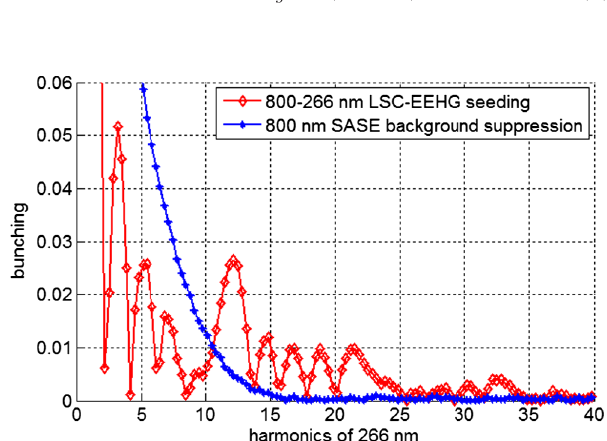
FIG. 5. 3D beam harmonics of 266 nm after last chicane for seeded and lasing suppressed portions of the beam from Fig. 4. Seeding was done with 800 nm in the tails and with a combination of 800 nm and 266 nm in the central spike. 8 nm is the 33rd harmonic of 266